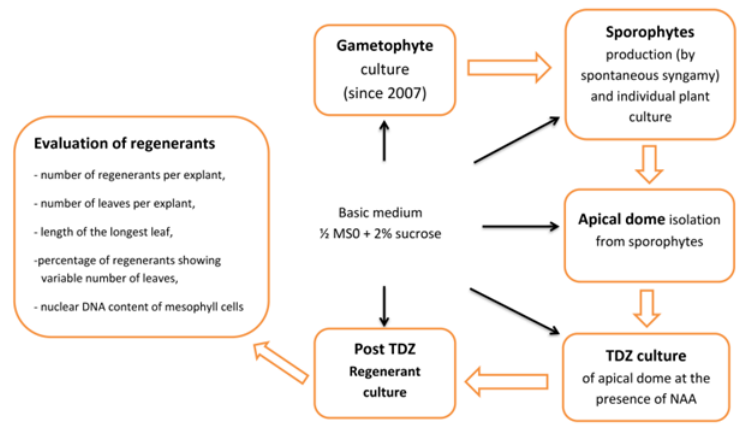
Figure 1 Culture stages with the source of initial explants and evaluation of regenerants